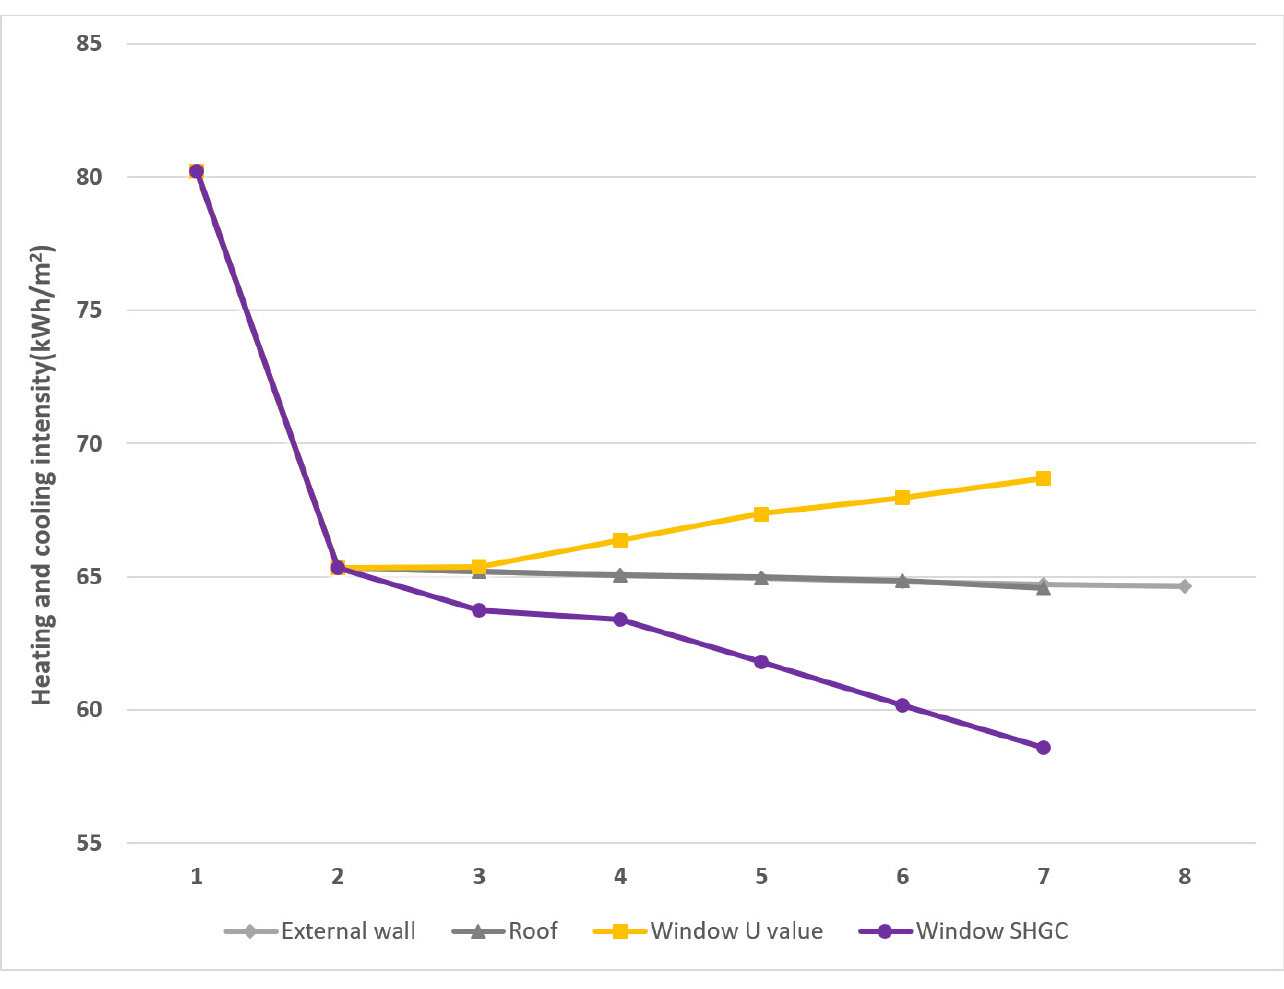
Figure 10. Comparison of the impact of U-value of external walls, U-value of roof, U-value of windows, and SHGC value of windows.